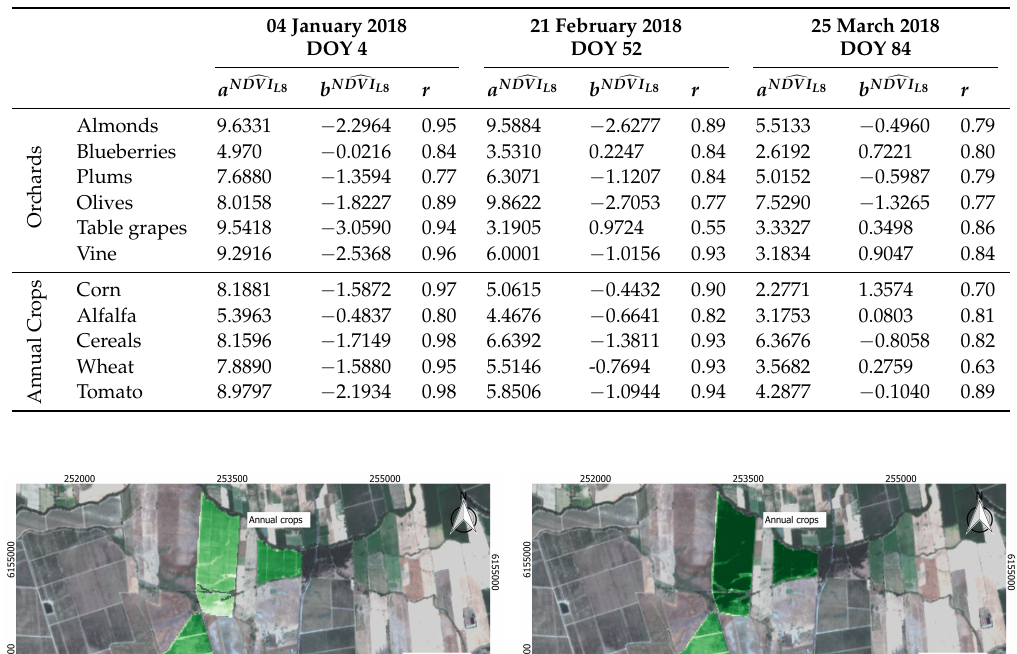
Table 4. Coefficients of linear fit between evapotranspiration ( ET L 8 ) and NDVI L 8 and Pearson correlation coefficient ( r ) for orchards and annual crops on the three analyzed days.